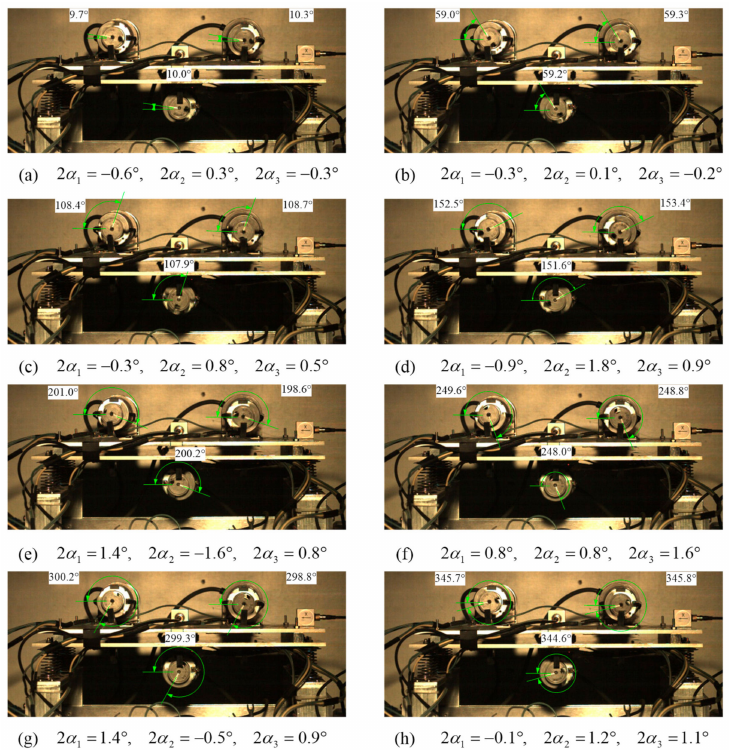
Figure 14. The phase difference of control synchronization of three ERs in the clockwise rotational direction. ( a – h ) are photos of continuous time intervals of 200